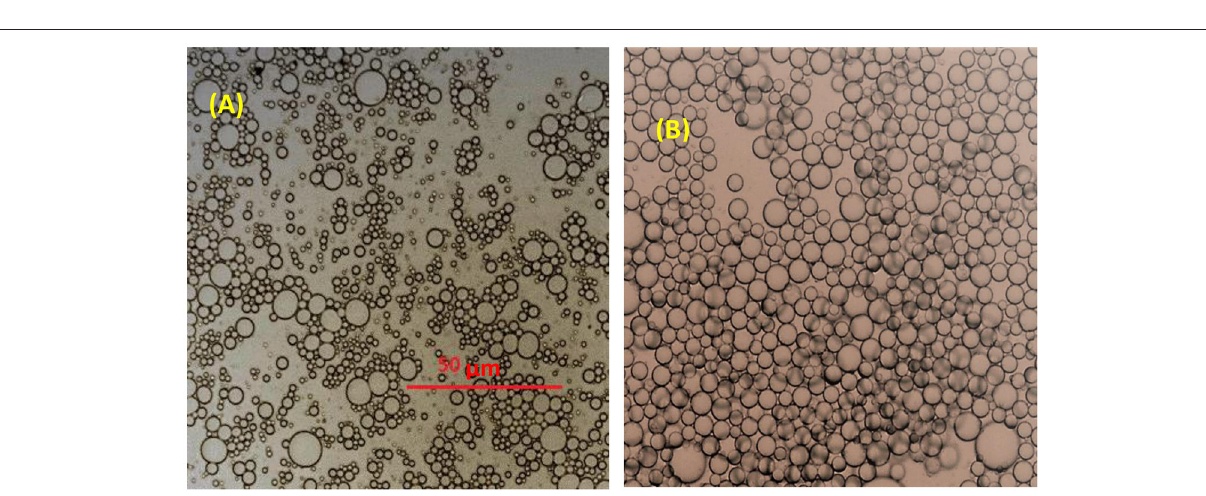
FIGURE 4 | Microscopic image of emulsions stabilized with 3 wt% CNC (A) C. Oil/water (B) hexadecane/water